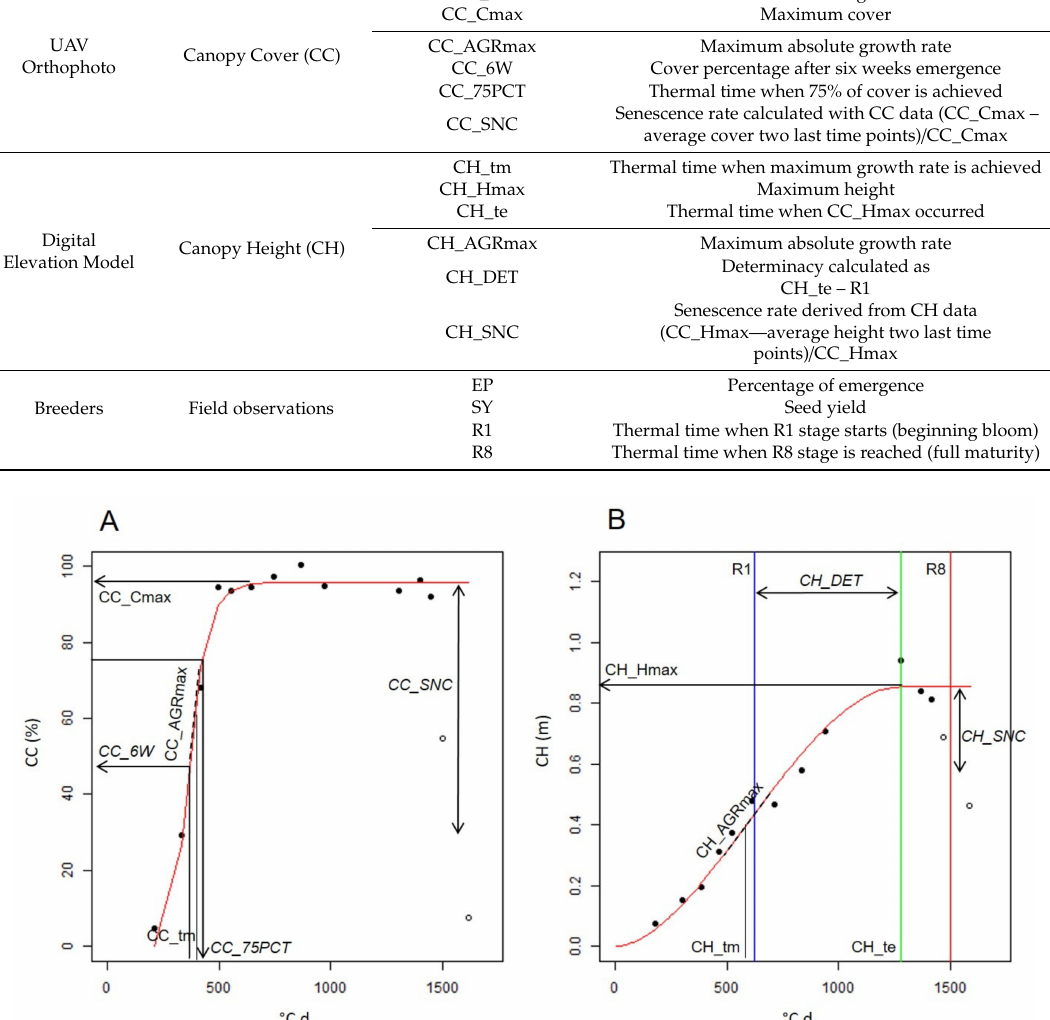
Figure 2. Schematic representation of the phenotypic parameters derived from the curve fitting for ( a ) canopy cover using the Gompertz function and ( b ) canopy height using the Beta function. For abbreviations and explanations of the parameters, see Table